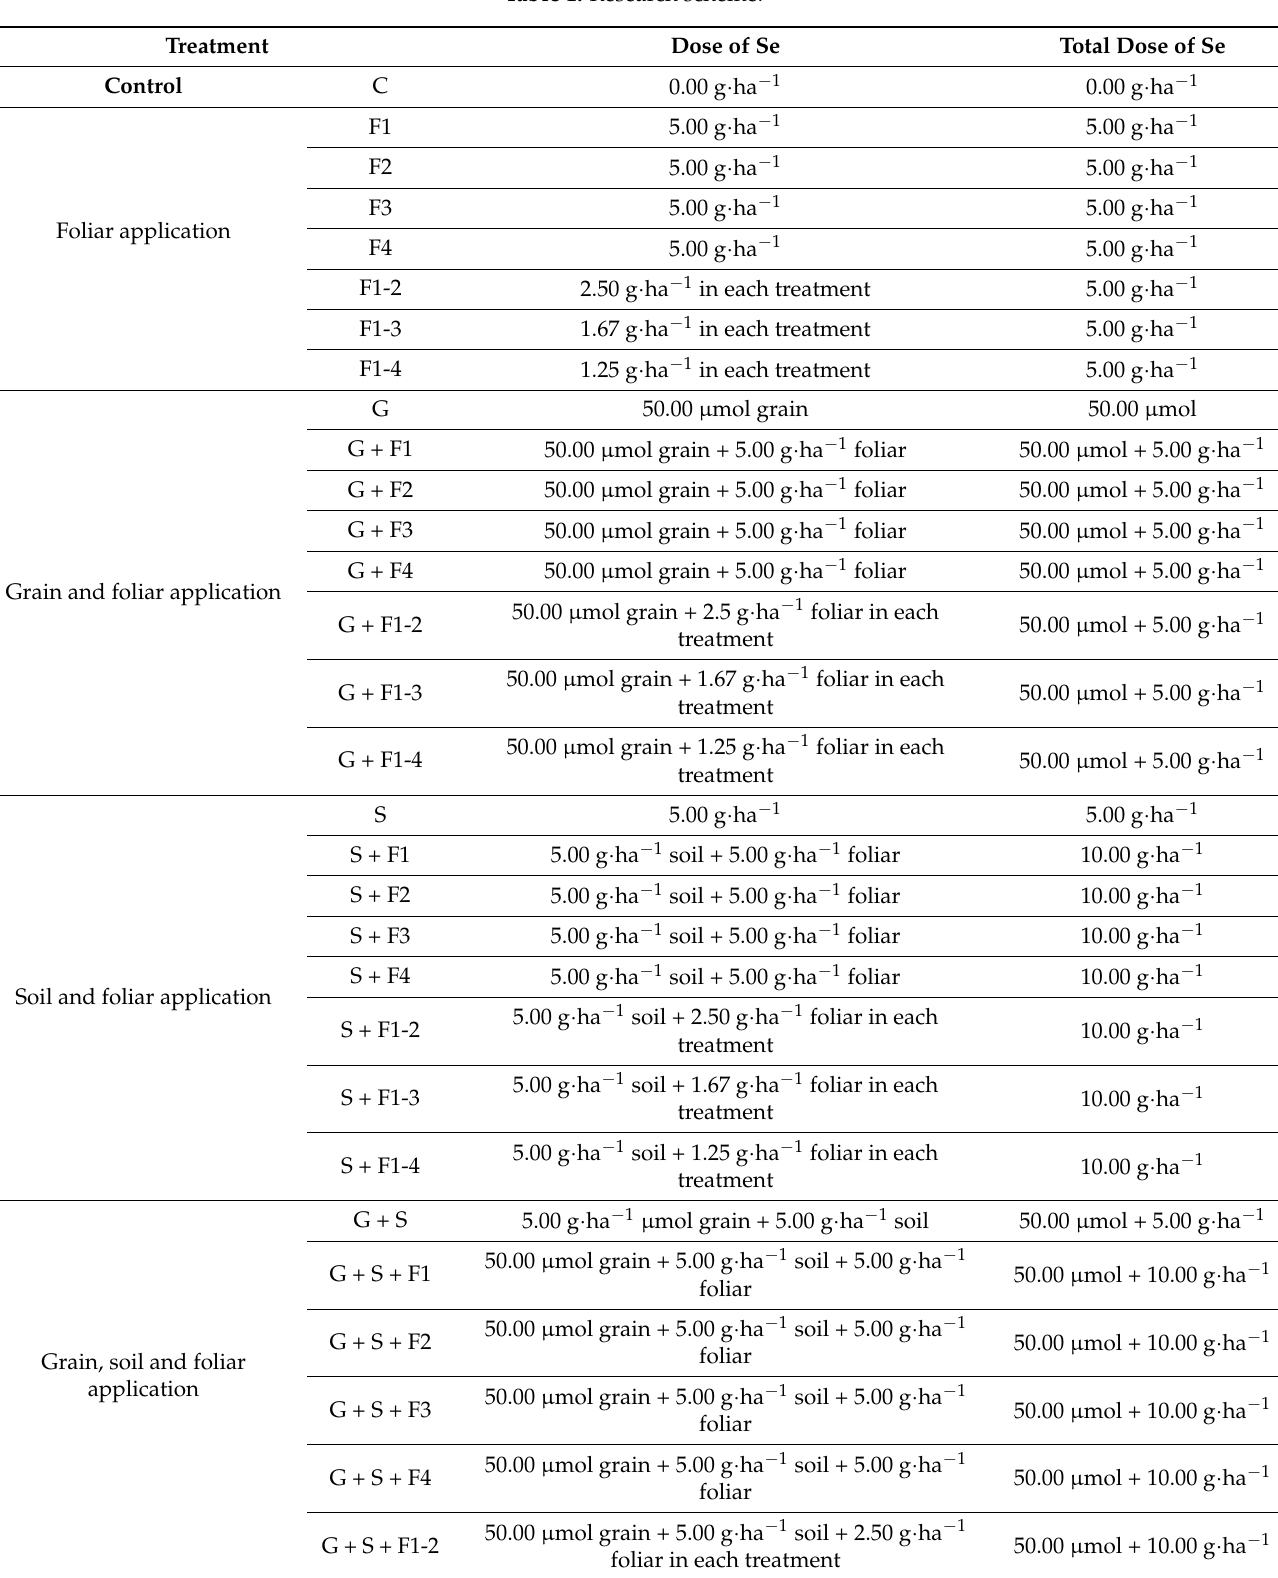
Table 1. Research